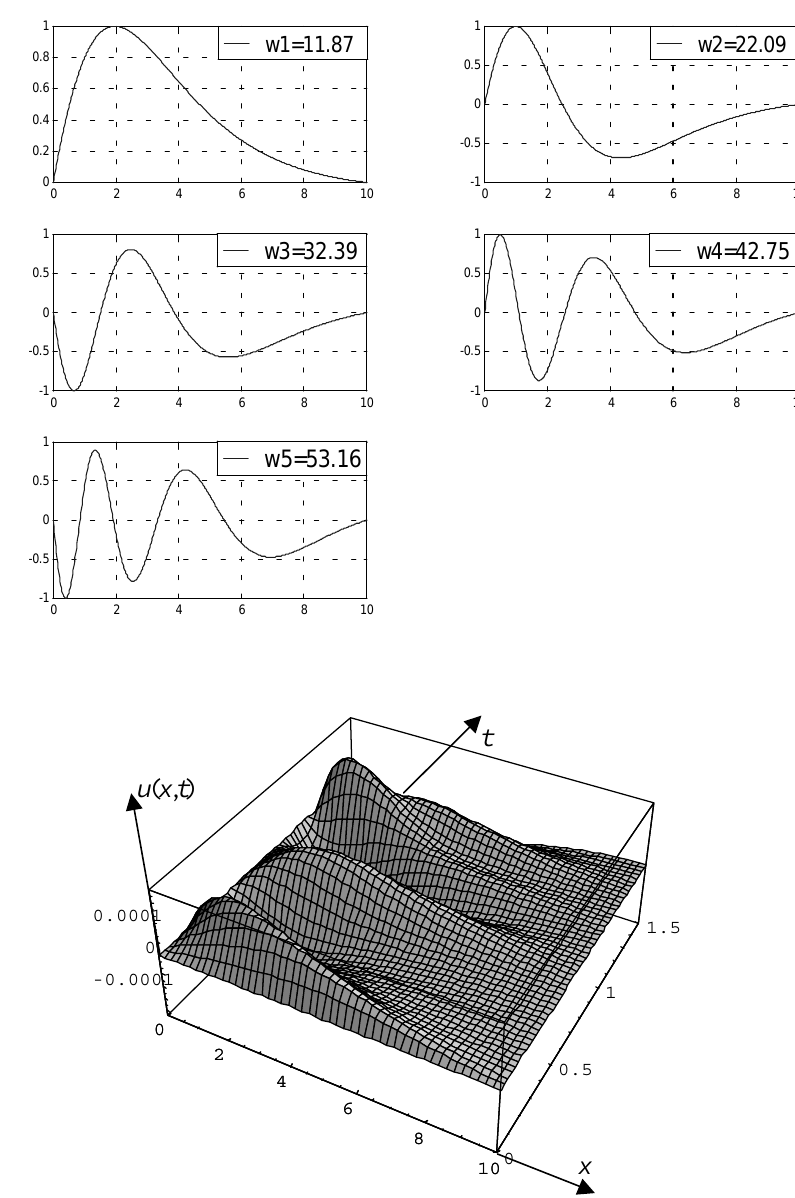
Fig. 6. First five eigenfunctions and time response of an aluminum fixed-free rod with an exponentially increasing modulus of